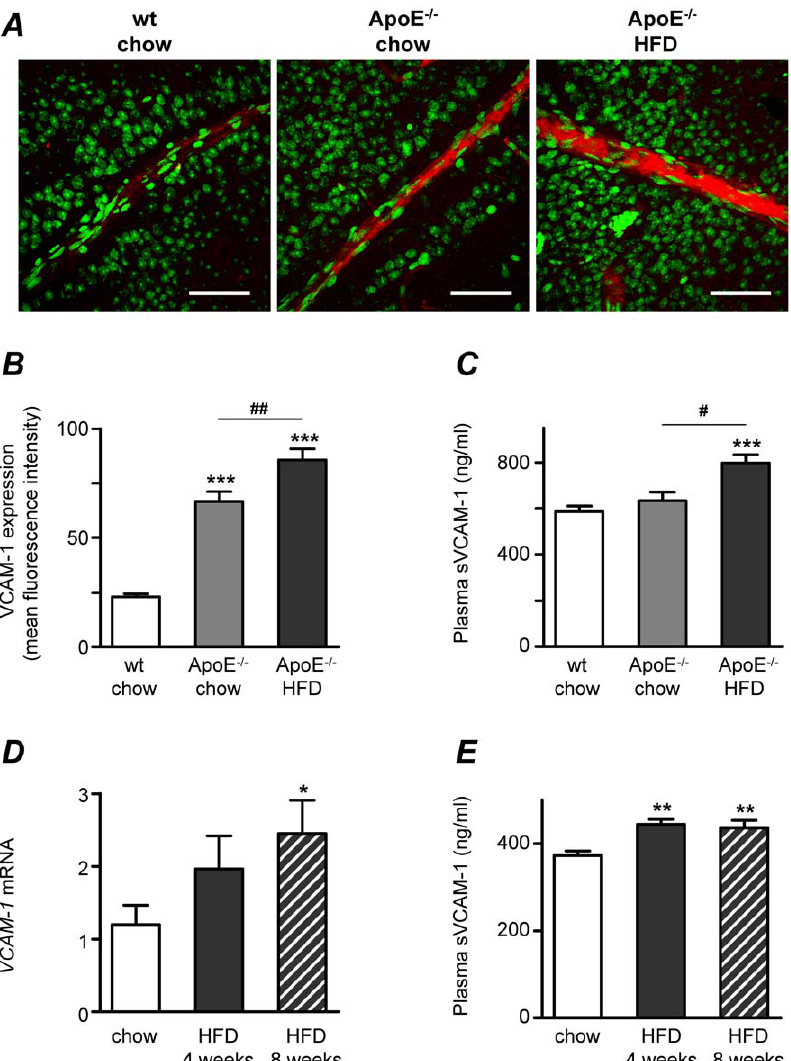
Figure 5. High fat diet (HFD) increases VCAM-1 expression in retinal vessels. ( A ) Confocal immunofluorescence microscopy images showing VCAM-1 expression (red) and nuclei stained by SYTOX (green) in retinal whole-mounts from wt mice fed normal chow diet and from ApoE 2 / 2 mice fed normal chow or 4 weeks of HFD. Bars=50 m m. Measurements were performed when mice were 17 weeks of age. ( B ) Summarized data from experiments as in A , showing increased mean fluorescence intensity of VCAM-1 in ApoE 2 / 2 (light gray bar) when compared to wt controls (white bar; *** p , 0.001) and further increased VCAM-1 expression in response to HFD (dark gray bar; ## p , 0.01). ( C ) Mean sVCAM-1 concentrations in plasma from the same mice used in A and B . *** p , 0.001 vs. wt chow and # p , 0.05 for differences between ApoE 2 / 2 groups (chow vs. HFD). ( D ) Expression of VCAM-1 mRNA was studied by real time RT-PCR in normolipidemic FVBN mice. Expression was enhanced by 4 or 8 weeks of HFD (plain and patterned gray bars, respectively) when compared to mice fed regular chow diet (white bars). The effects were significant after 8 weeks (* p , 0.05). Values are normalized to the expression of cyclophilin B and GAPDH. ( E ) Mean sVCAM-1 concentrations in plasma from the same mice used in D . ** p , 0.01 vs. wt